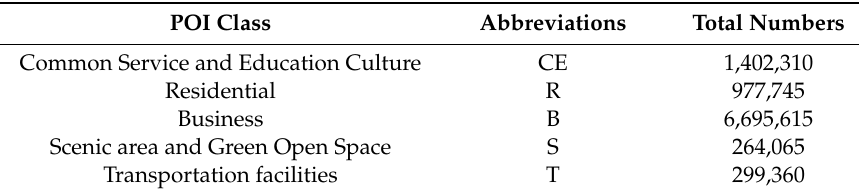
Table 1. Summary statistics of the POIs.